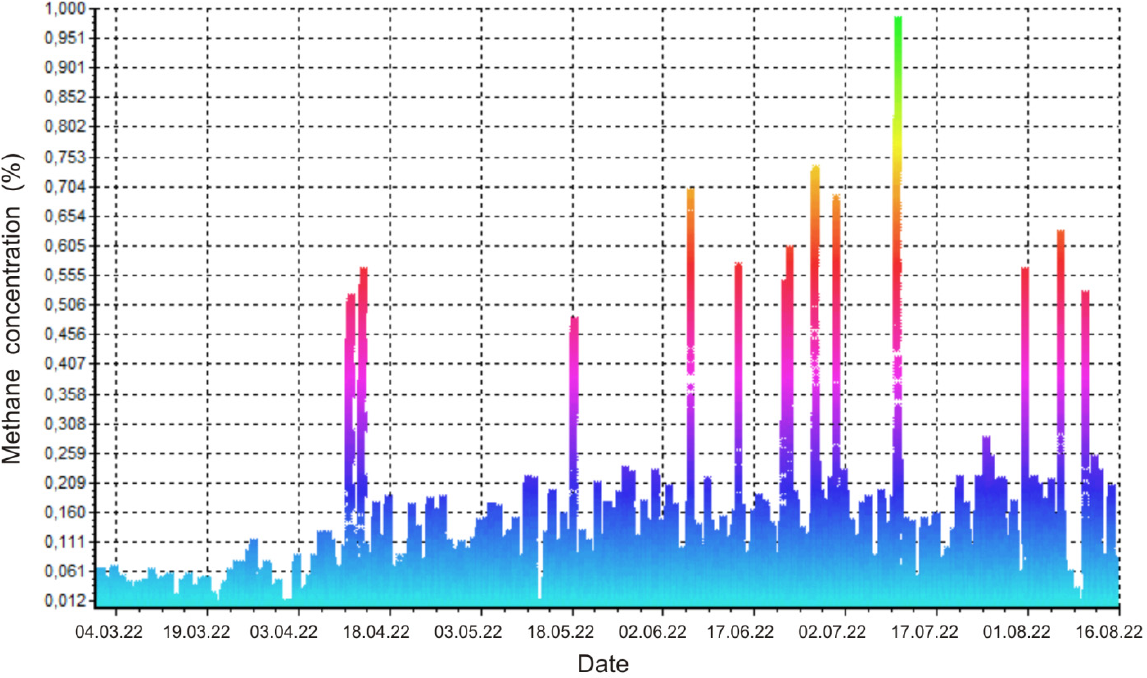
Figure 11. Seasonal dynamics of measured methane (CH 4 ) concentration in near-surface air.